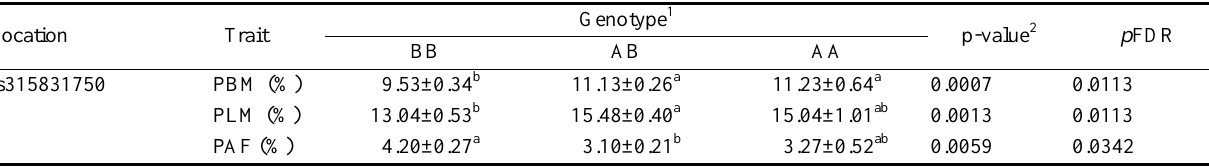
Table 4. Effect of single SNP genotype on carcass